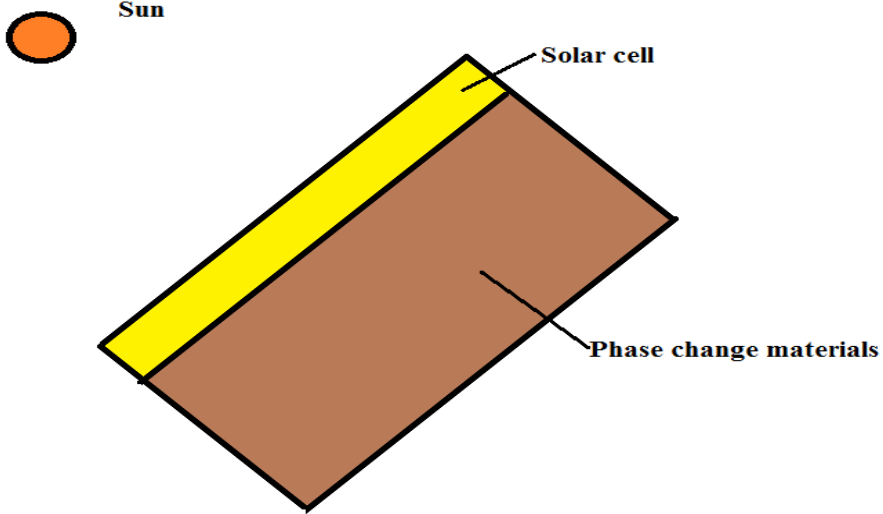
Figure 2. The basic structure of PCMs in PV application.